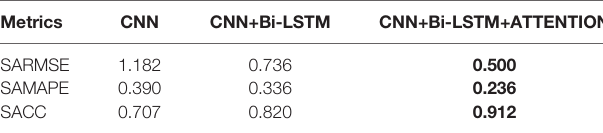
FIGURE 7 | Continuous prediction for twelve-hour prediction. (A – C) are the prediction results of the CNN model, the ERA5 data results, and the prediction errors, respectively. (D – F) are the prediction results of the CNN + Bi-LSTM model, the ERA5 data results, and the prediction errors, respectively. (G – I) are CBA-Net model prediction results, ERA5 data results, and prediction errors, respectively. TABLE 3 | One-day performance